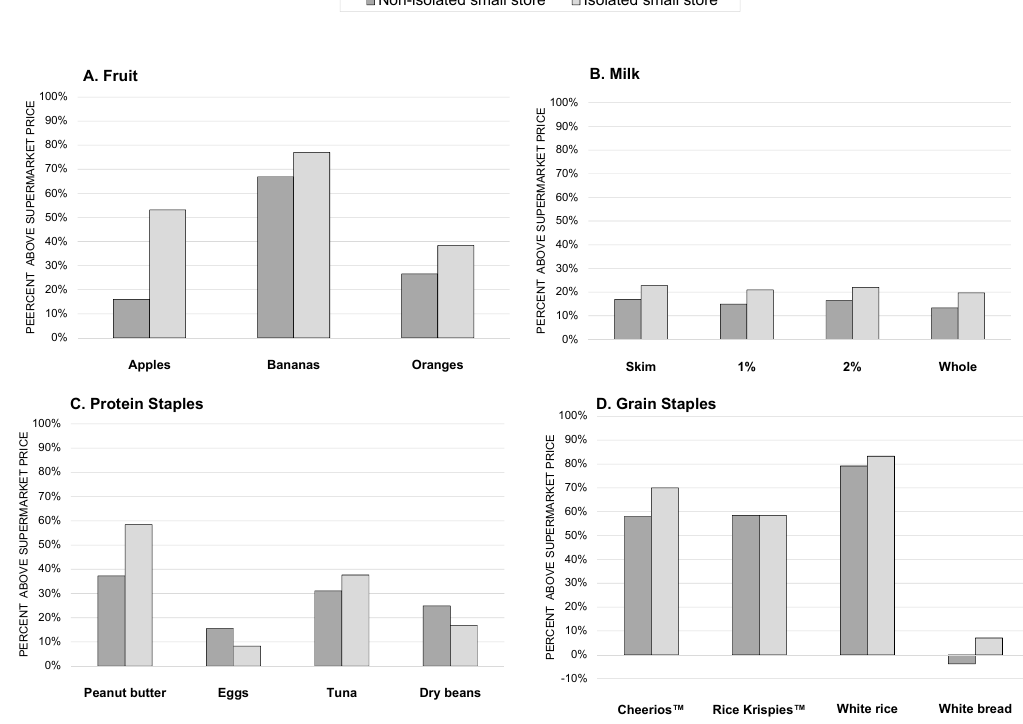
Figure 1. Price Differentials for Items at Small Food Stores by Store Isolation Status, Minneapolis and St. Paul, MN, 2014.